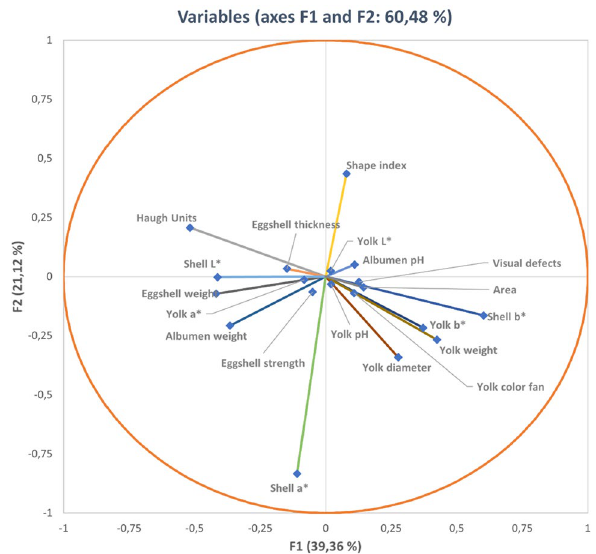
Figure 3. Vector plot for discriminant loadings for egg quality-related traits.